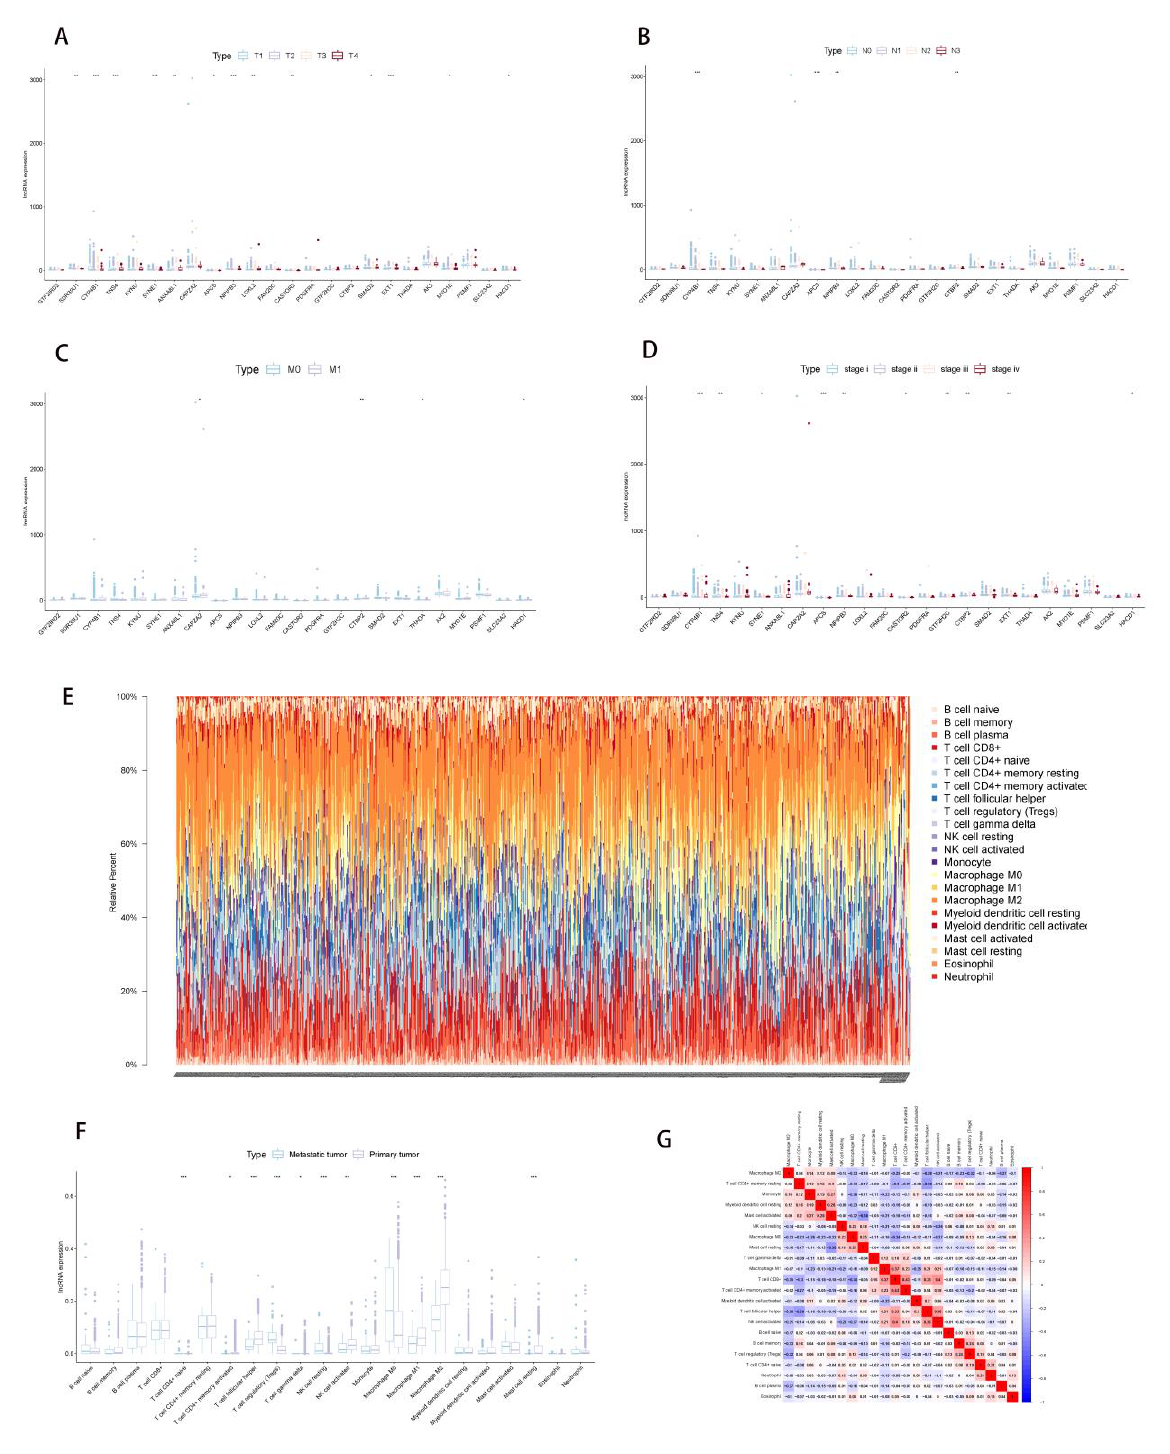
Figure 4. Clinical correlation analysis and immune infiltration analysis. ( A – D ) Boxplots showed the LncRNA expression of 24 PDEEs in each TNM staging and stage of NSCLC. ( E ) CIBERSORT algorithm estimated the composition of 22 immune cells in entire NSCLC samples. ( F ) The immune cells that were differentially expressed between primary NSCLC and metastatic NSCLC, purple color and blue color represented primary NSCLC and metastatic NSCLC, respectively. ( G ) Co-expression analysis in entire 22 immune cells. NSCLC, Non-small cell lung cancer.